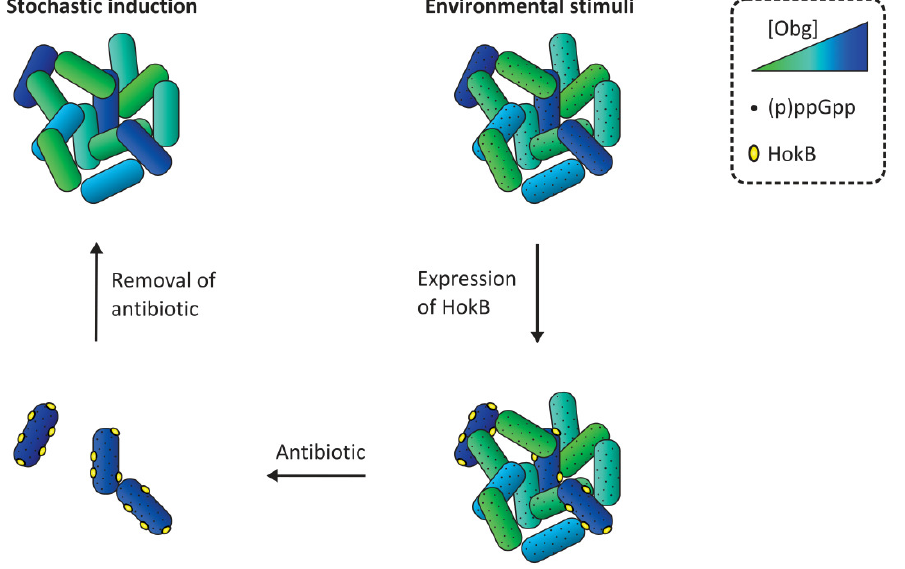
FIGURE 1 : A model for Obg- mediated persistence. Stochastic fluctuations in Obg concentra- tions drive expression of HokB in a (p)ppGpp-dependent manner. HokB protects the cells from antibiotic attack by reducing the membrane potential. Persister cells surviving antibiotic treat- ment give rise to a new popula- tion. See text for